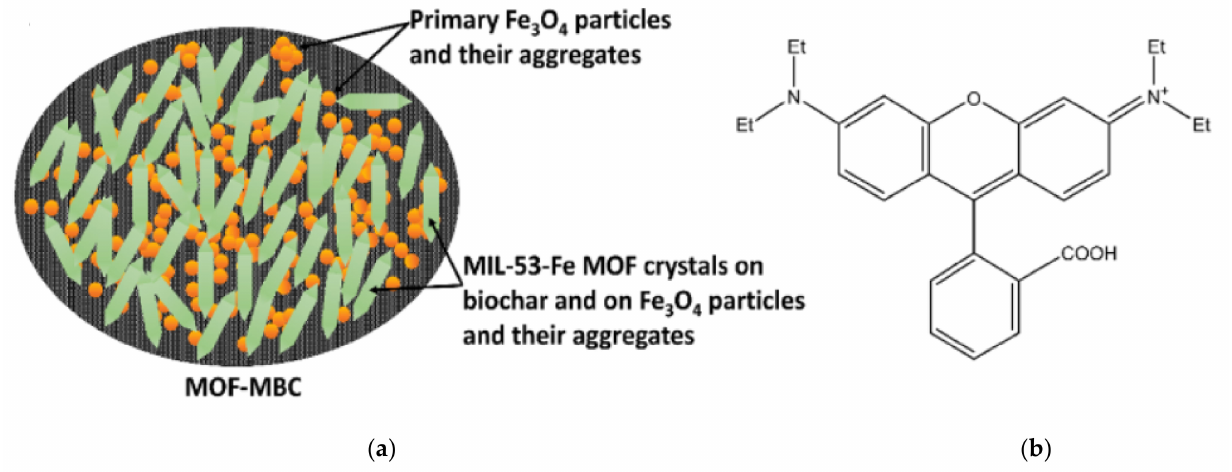
Figure 24. Schematic representation of ( a ) MOF–MBC and ( b ) the chemical structure of Rhodamine B. Reprinted with permission from